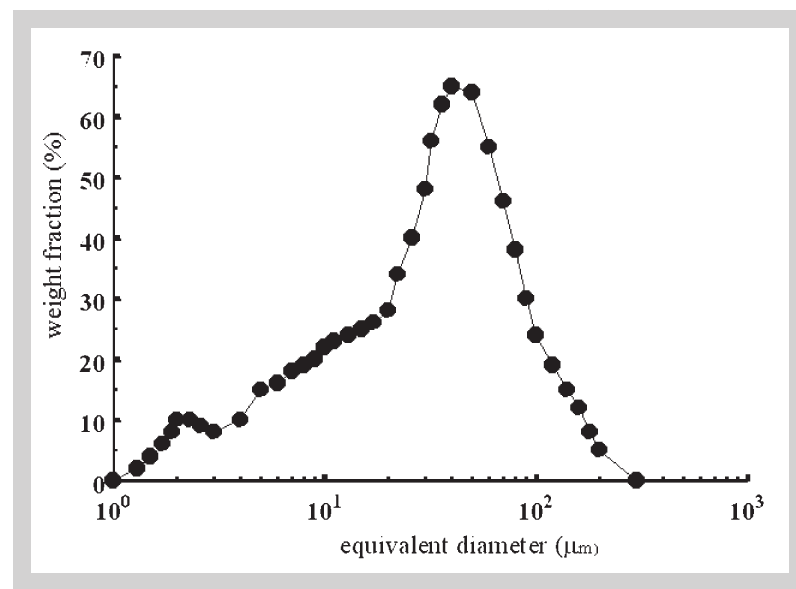
Figure 1: Granulometric profile of the mud: the weight fraction of particles as a function of their equivalent